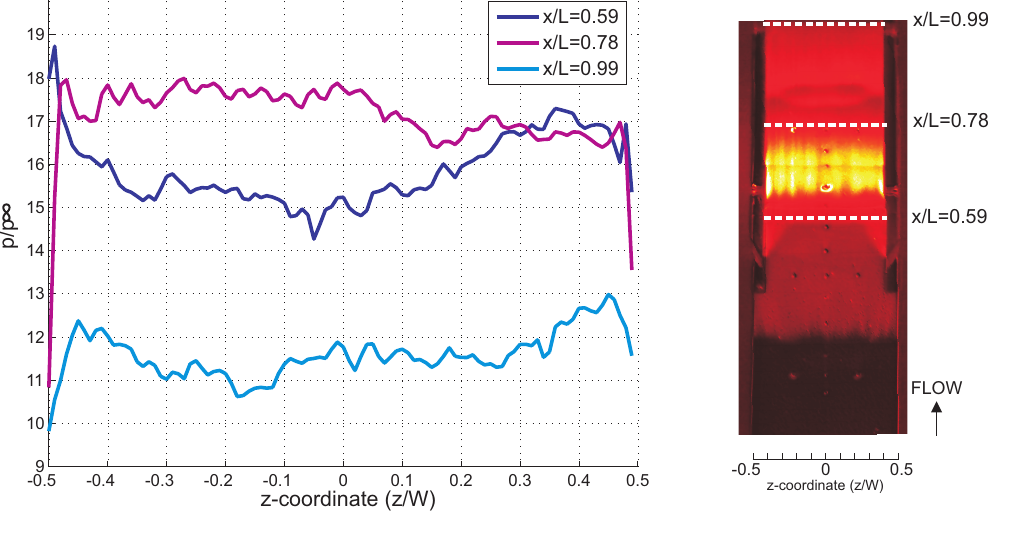
Figure 17. Normalized spanwise static pressure for the AoA-4 case taken at the isolator entrance x / L = 0.59, the middle of the isolator x / L = 0.78 and the isolator exit x / L = 0.99.